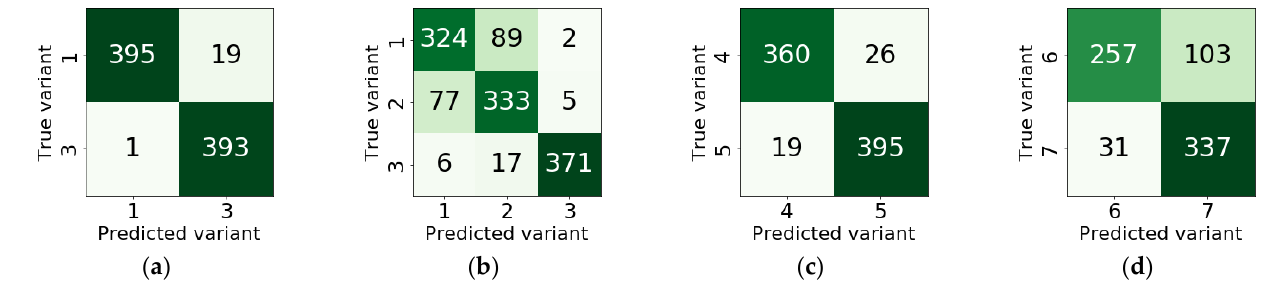
Figure 10. Confusion matrices: ( a ) Variant 1 vs. 3; ( b ) Variant 1 vs. 2 vs. 3; ( c ) Variant 4 vs. 5; ( d ) Variant 6 vs. 7.